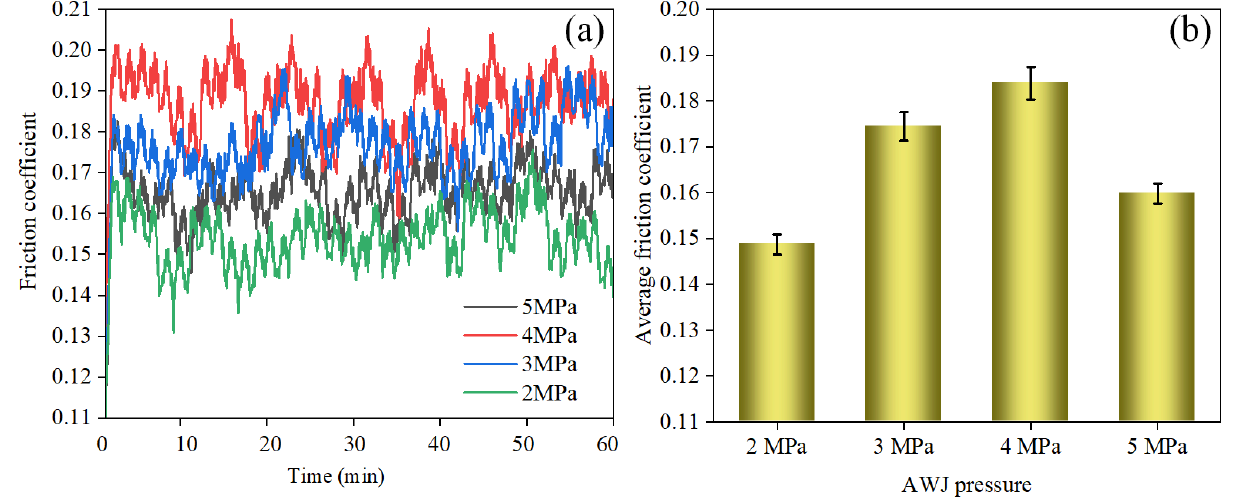
Figure 12. Friction coefficient for AWJ-dressed FAP at four pressures: ( a ) friction coefficient; ( b ) average friction